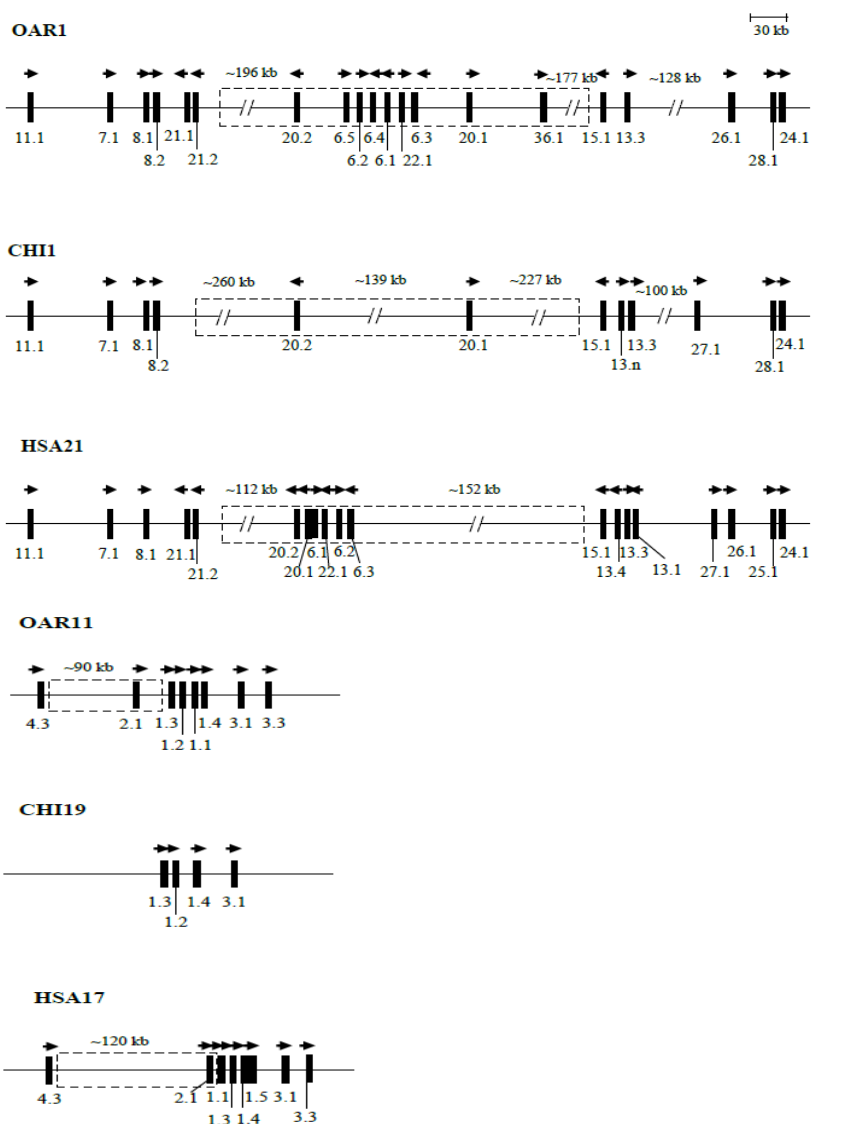
Figure 6. Chromosomal locations of the KRTAP s identified in sheep and goats together with their human orthologues. A vertical bar represents each KRTAP and the arrowheads above the bars indicate the direction of transcription. The numbers below the bars indicate the name of the KRTAP s (i.e., 11.1 represents KRTAP11-1 ). The distances between the KRTAP s are only approximate. The dashed-line boxes represent the chromosome regions that appear to be markedly different between sheep/goats and humans. Note that human KRTAP1-4 , KRTAP1-3 , KRTAP1-1 , and KRTAP1-5 are the orthologues of ovine KRTAP1-1 , KRTAP1-2 , KRTAP1-3 , and KRTAP1-4 , respectively.